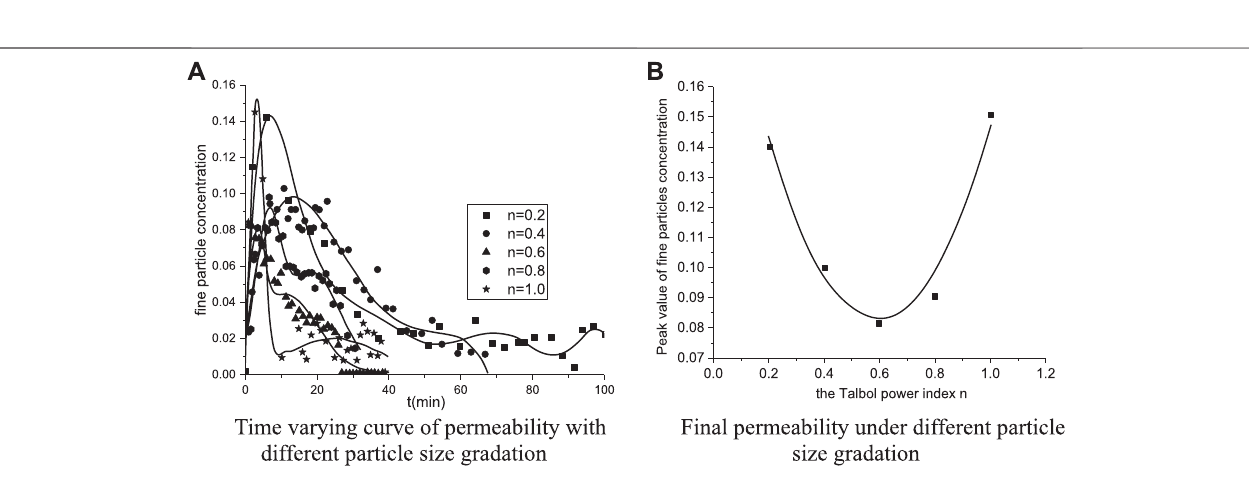
Frontiers in Earth Science |